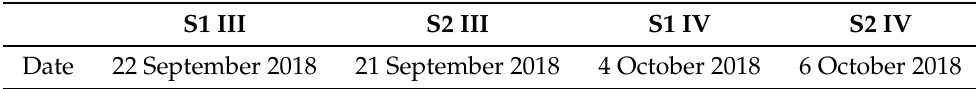
Table 2. The meaning of the pixel values and the formats of Sentinel-1 and Sentinel-2 in this dataset were the same as those in Dataset A. Table 2. The times of the Sentinel-1/Sentinel-2 image pairs.